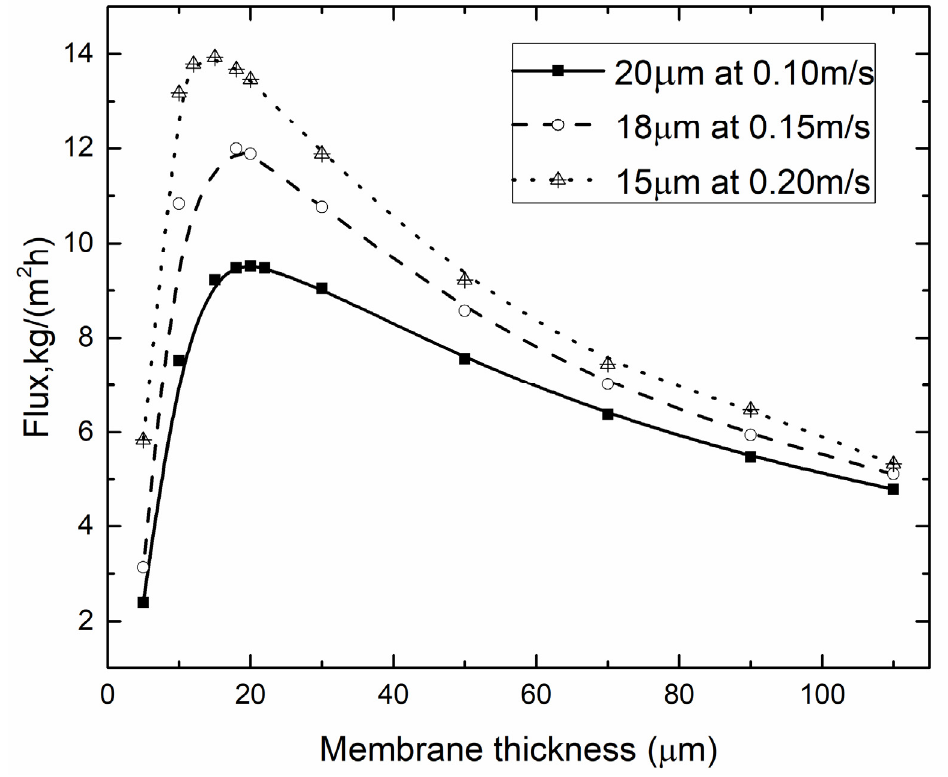
Figure 14. Optimal membrane thickness for different v f , v p ( T f = 45 °C, T p = 25 °C, c f = 24.2 wt.%, GVHP).